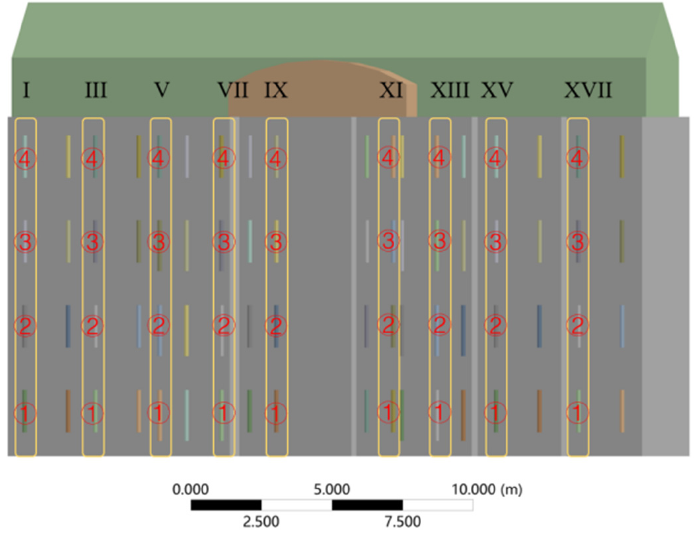
Figure 9. Schematic diagram of north-facing sun visors.